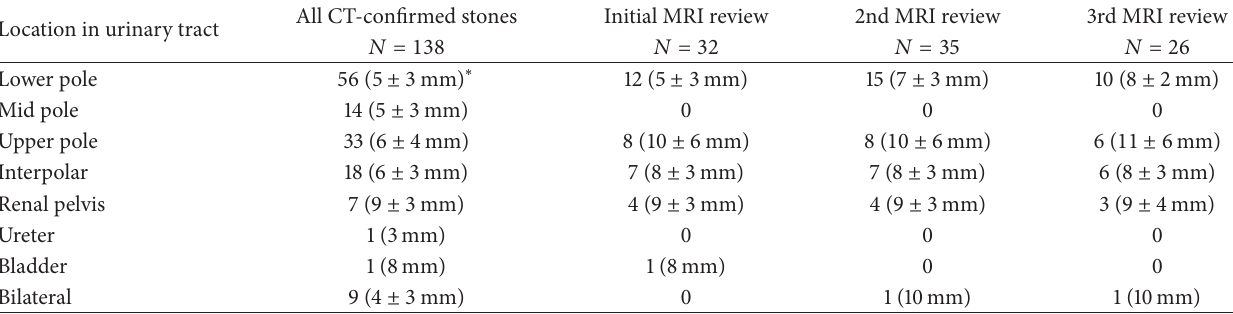
Table 1: Stone location by